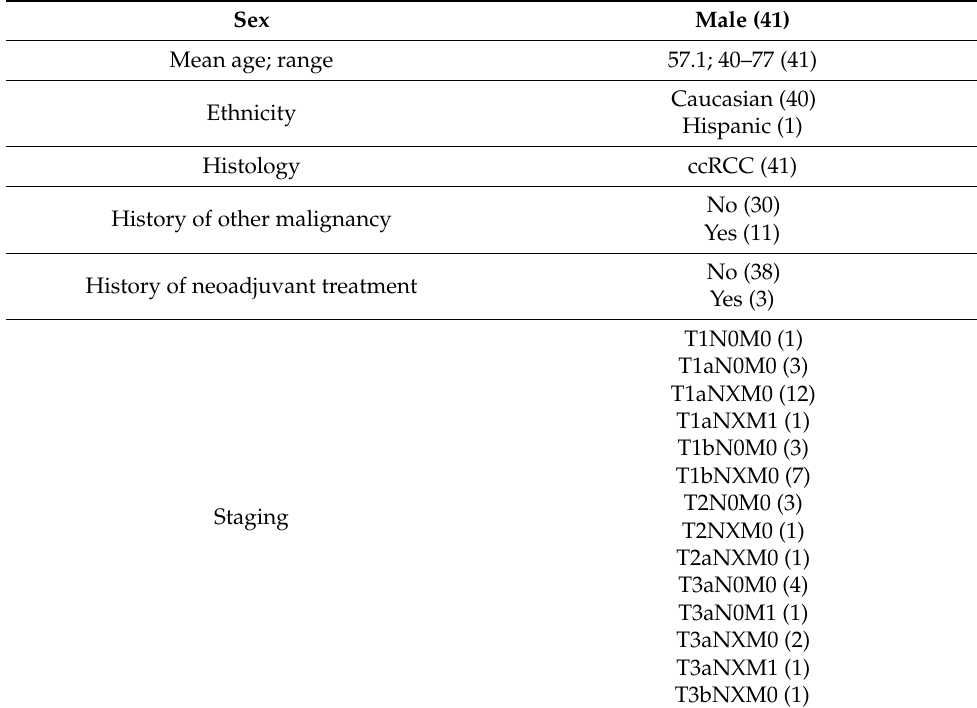
Table 1. Descriptive data of ccRCC-VHL